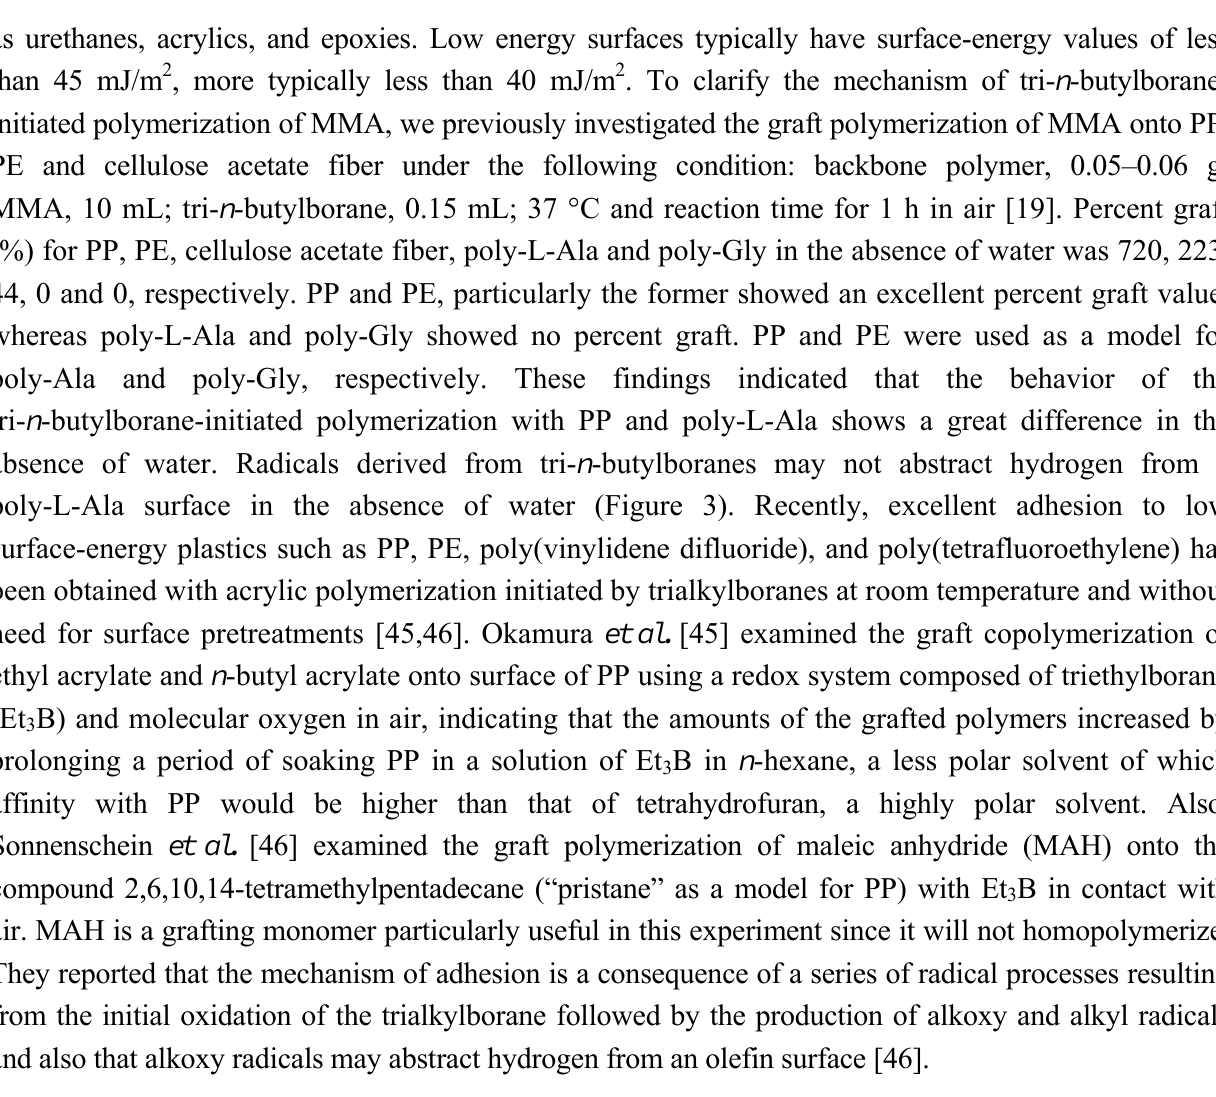
Figure 3. A possible mechanism of H-abstraction by alkoxy radical from a polypropylene surface. An H-abstraction from poly-L-Ala alpha-carbon possibly does not